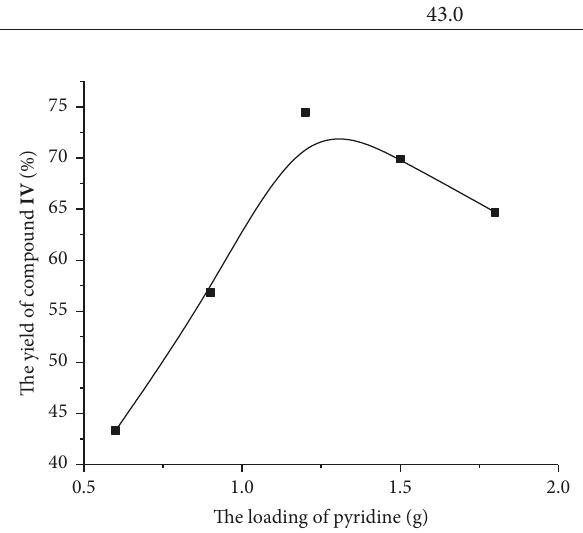
Figure 7: Impact of catalyst